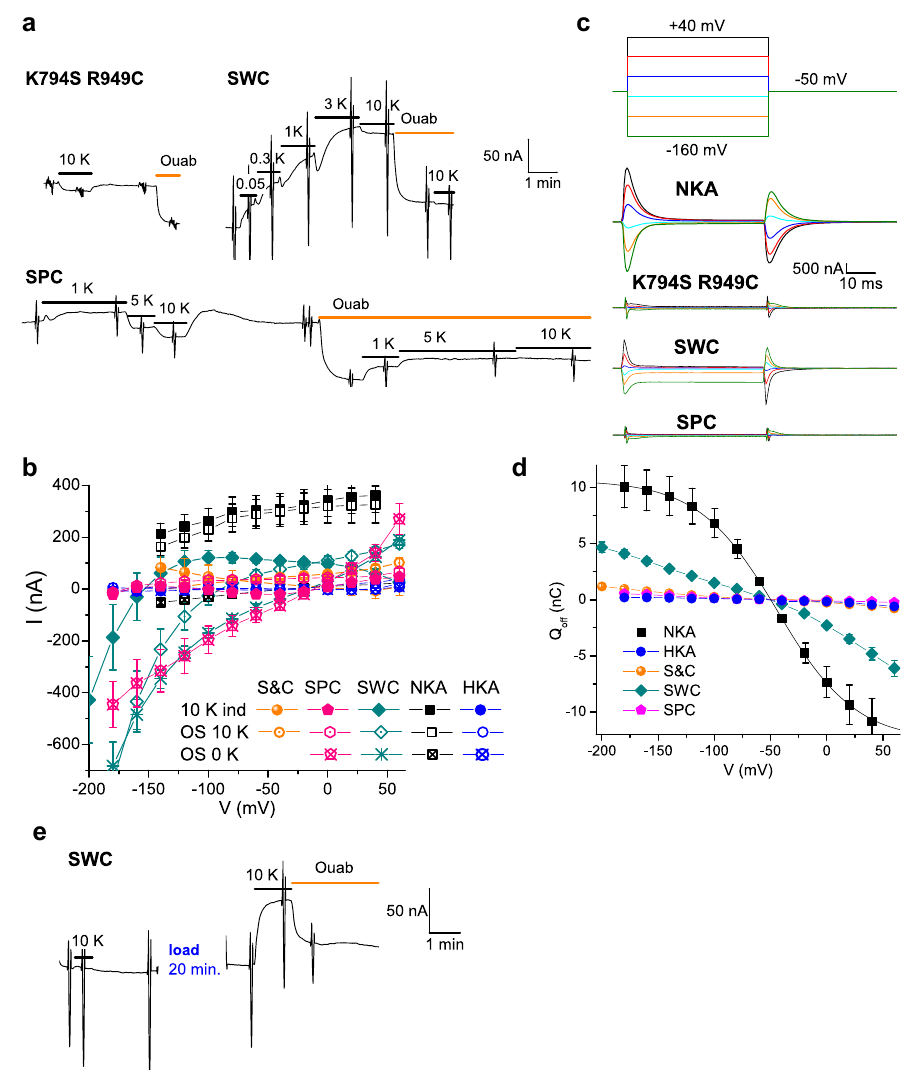
Fig. 4 | Functional analysis of “ intermediate ” ngHKA mutants. a Current at − 50mV from a Na + -loaded oocytes expressing K794S/R949C-, SWC-, or SPC- ngHKA. Application of K + induced a small inward current in oocytes expressing K794S/R949C-ngHKA, whereas it activated outward currents in SWC-ngHKA expressing oocytes. In contrast, SPC expressing oocytes showed small outward currents at low ( ≤ 1mM) K + , but large dose-dependent inward currents at higher [K + ]. Ouabain application causes an inward de fl ection of the current in K794S/ R949C-, and SPC-ngHKA, indicating that these mutants perform an electrogenic transport mode without K + . Vertical de fl ections correspond to the application of 50-mslongpulses(seenataslowsamplingrate)tovoltagesrangingbetween − 160 and +40mV to construct I – V plots. b Mean steady-state I – V for the 10mMK + - induced current (solid symbols), the ouabain-sensitive current in 10mMK + (open symbols) and the ouabain-sensitive current without K + (crossed symbols) for K794S/R949C- (orange circles), SWC- (teal diamonds), SPC-ngHKA (pink